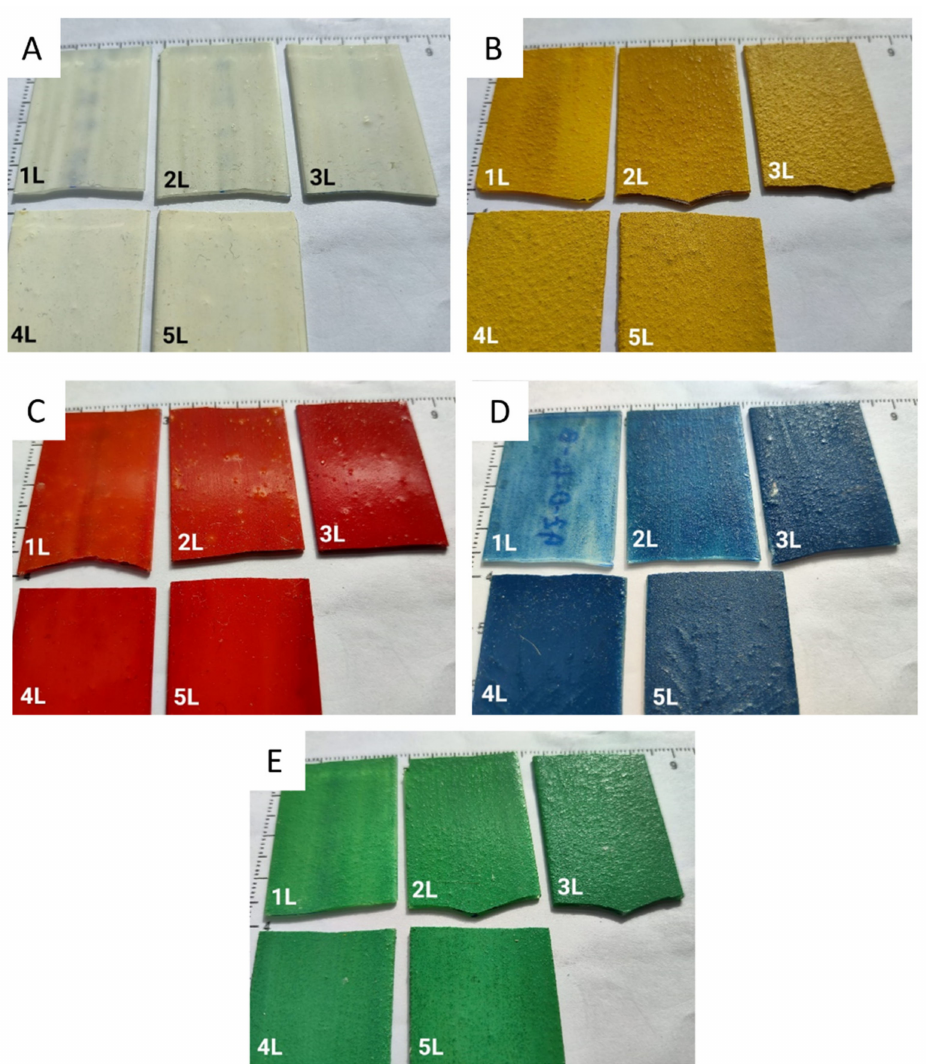
Figure 1. Painting mock-ups used to study the effect of the thickness of the paint layer (1L: one layer and 5L: five layers) on the reflectance. ( A ) Lead white (LW)-based oil painting mock-ups. ( B ) Orpiment (OR)-based oil painting mock-ups. ( C ) Cinnabar (CIN)-based oil painting mock-ups. ( D ) Azurite (AZ)-based soil painting mock-ups. ( E ) Malachite (MAL)-based oil painting